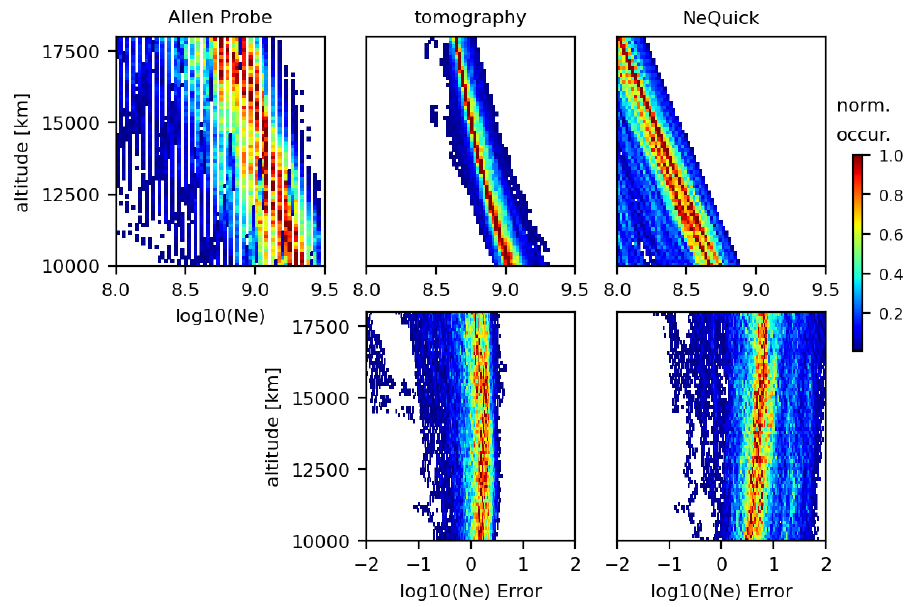
Figure 13. Same as Figure 12, but for the RBSP-B